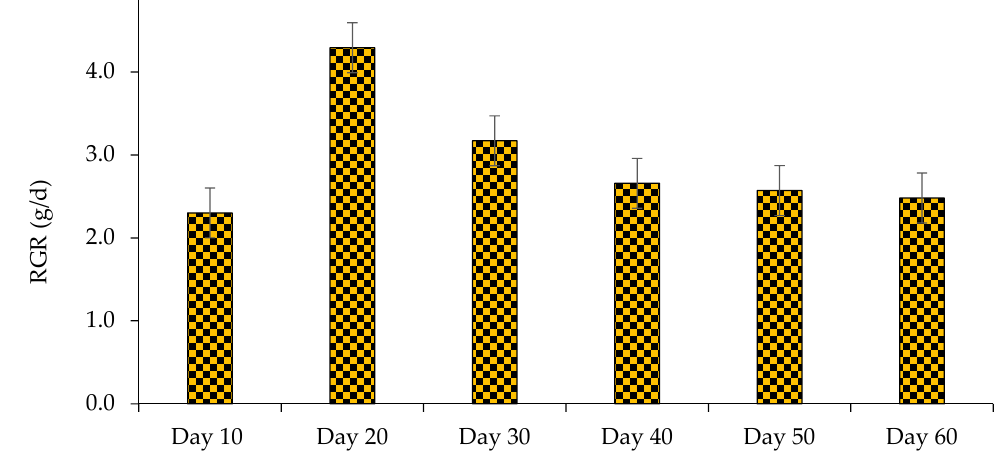
Figure 5. Relative growth rate of Caulerpa lentillifera.